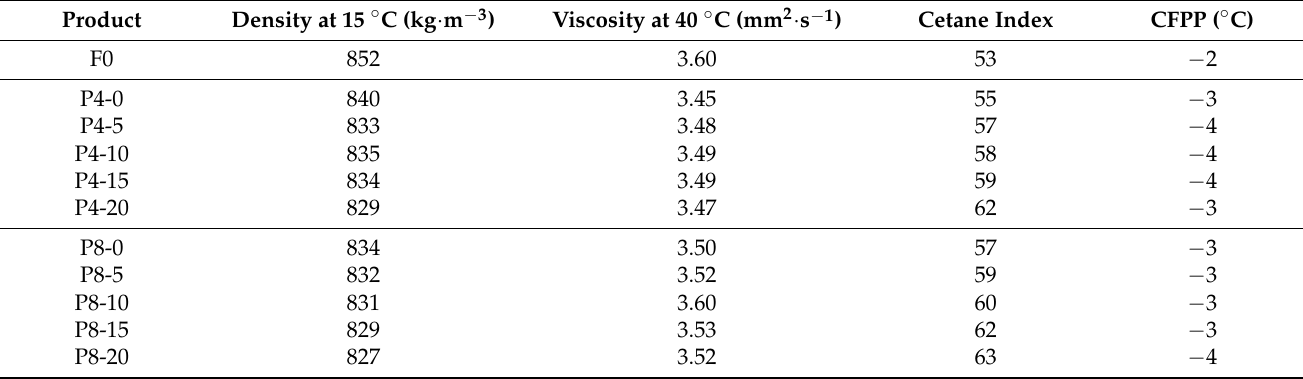
Table 5. Properties of the F0 feedstock and hydrotreated